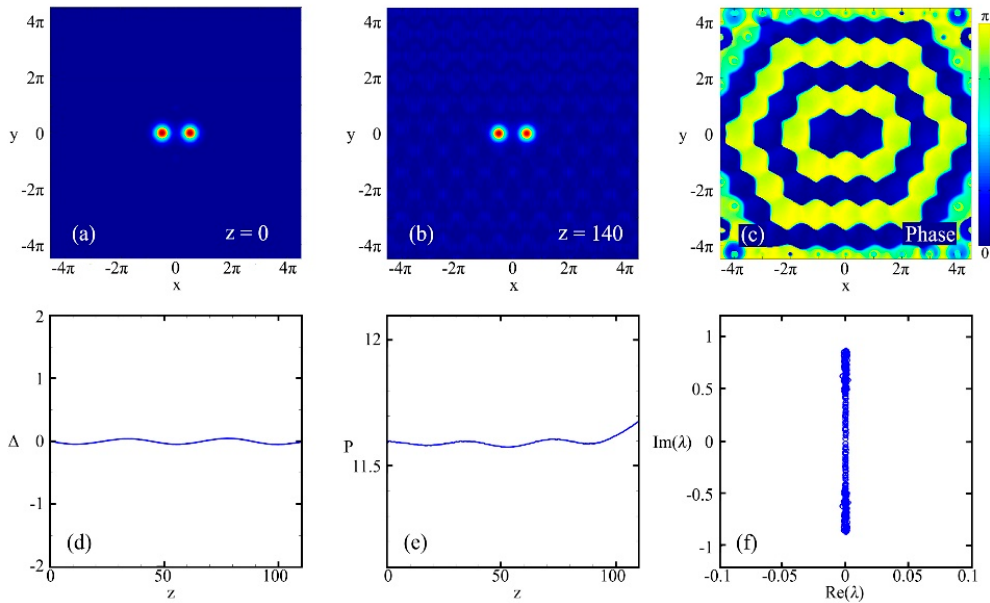
Figure 3. The evolution dynamics of stable dipole soliton with d = 0.5, µ = 9.6. ( a , b ) correspond to the transverse profile of solitons at z = 0 and z = 140, respectively. ( c ) is the phase structure of the dipole soliton. ( d , e ) correspond to the change of the gravity center, ∆ , and the power of the soliton, P , during propagation. ( f ) is the spectrum of the perturbation growth rate, where Im( λ ) and Re( λ ) are the imaginary part and the real part of the instability growth rate λ .